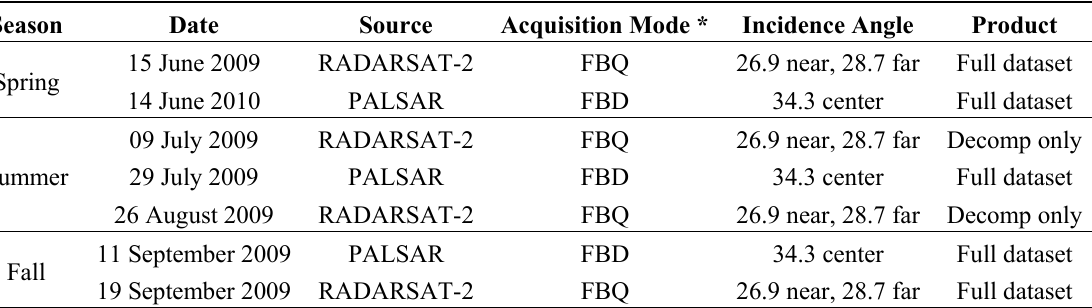
Table 4. Input radar data for decision tree